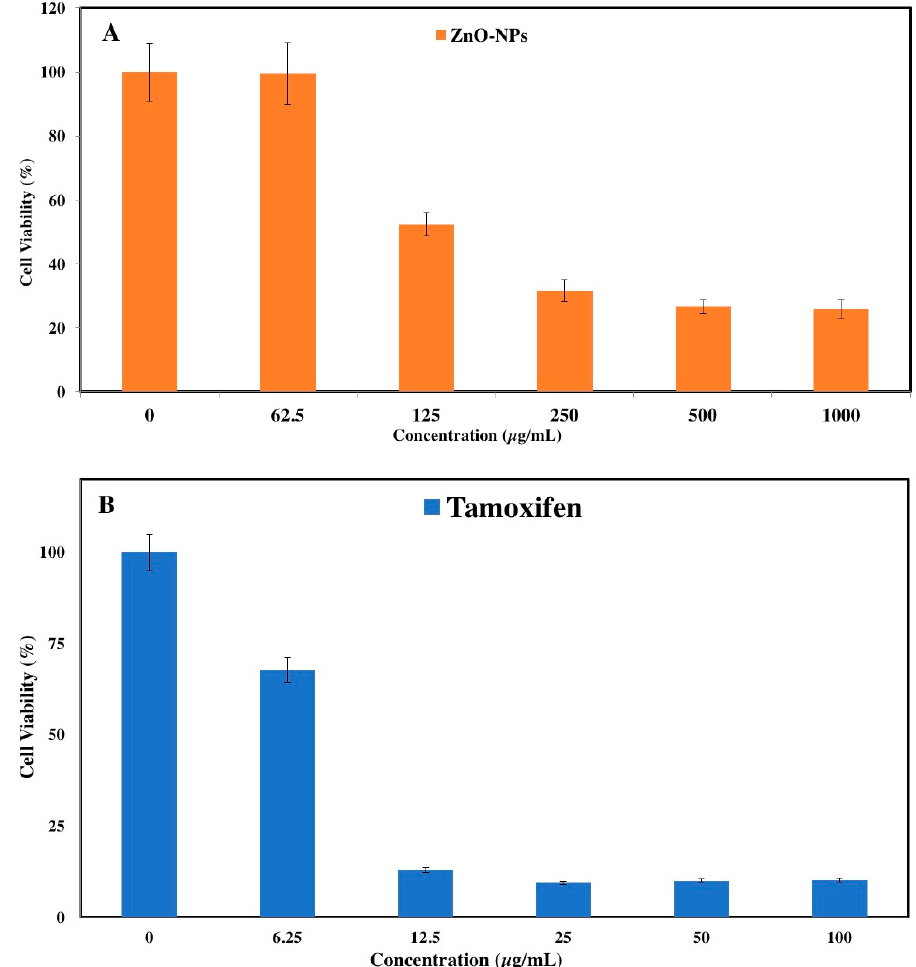
Figure 1. ( A ) Anti-proliferative activity of zinc oxide nanoparticles (ZnO NPs) with respect to MCF-7; ( B ) Effect of tamoxifen on MCF-7 cells.